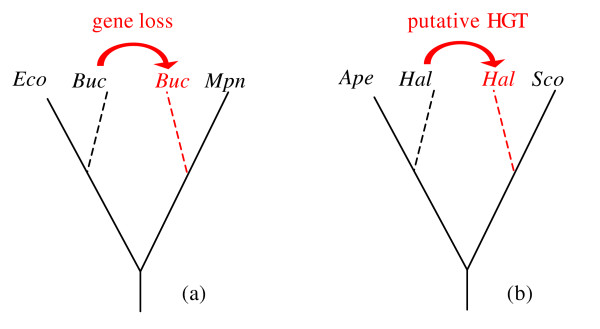
The differences between single pathway-based treesand 16S rRNA-based trees. (a) In the 16S rRNA-based tree, two γ-proteobacteria Buchnera aphidicola (Buc) and Escherichia coli (Eco) are clustered together. In the phylophenetic tree based on the topology of the glycolysis/gluconeogenesis (map00010), the obligate intracellular symbiont B. aphidicola (marked with red color) is clustered with the obligate intracellular parasite M. pneumoniae (Mpn), mainly due to the gene loss in the two organisms. (b) In the 16S rRNA-based tree, two archaea Halobacterium sp. NRC-1 (Hal) and Aeropyrum pernix (Ape) are clustered together. In the phylophenetic tree based on the topology of the selenoamino acid metabolism (map00450), Halobacterium (marked with red color) is clustered with actinobacteria Streptomyces coelicolor (Sco), mainly due to the putative horizontal gene transfer of selenocysteine lyase.